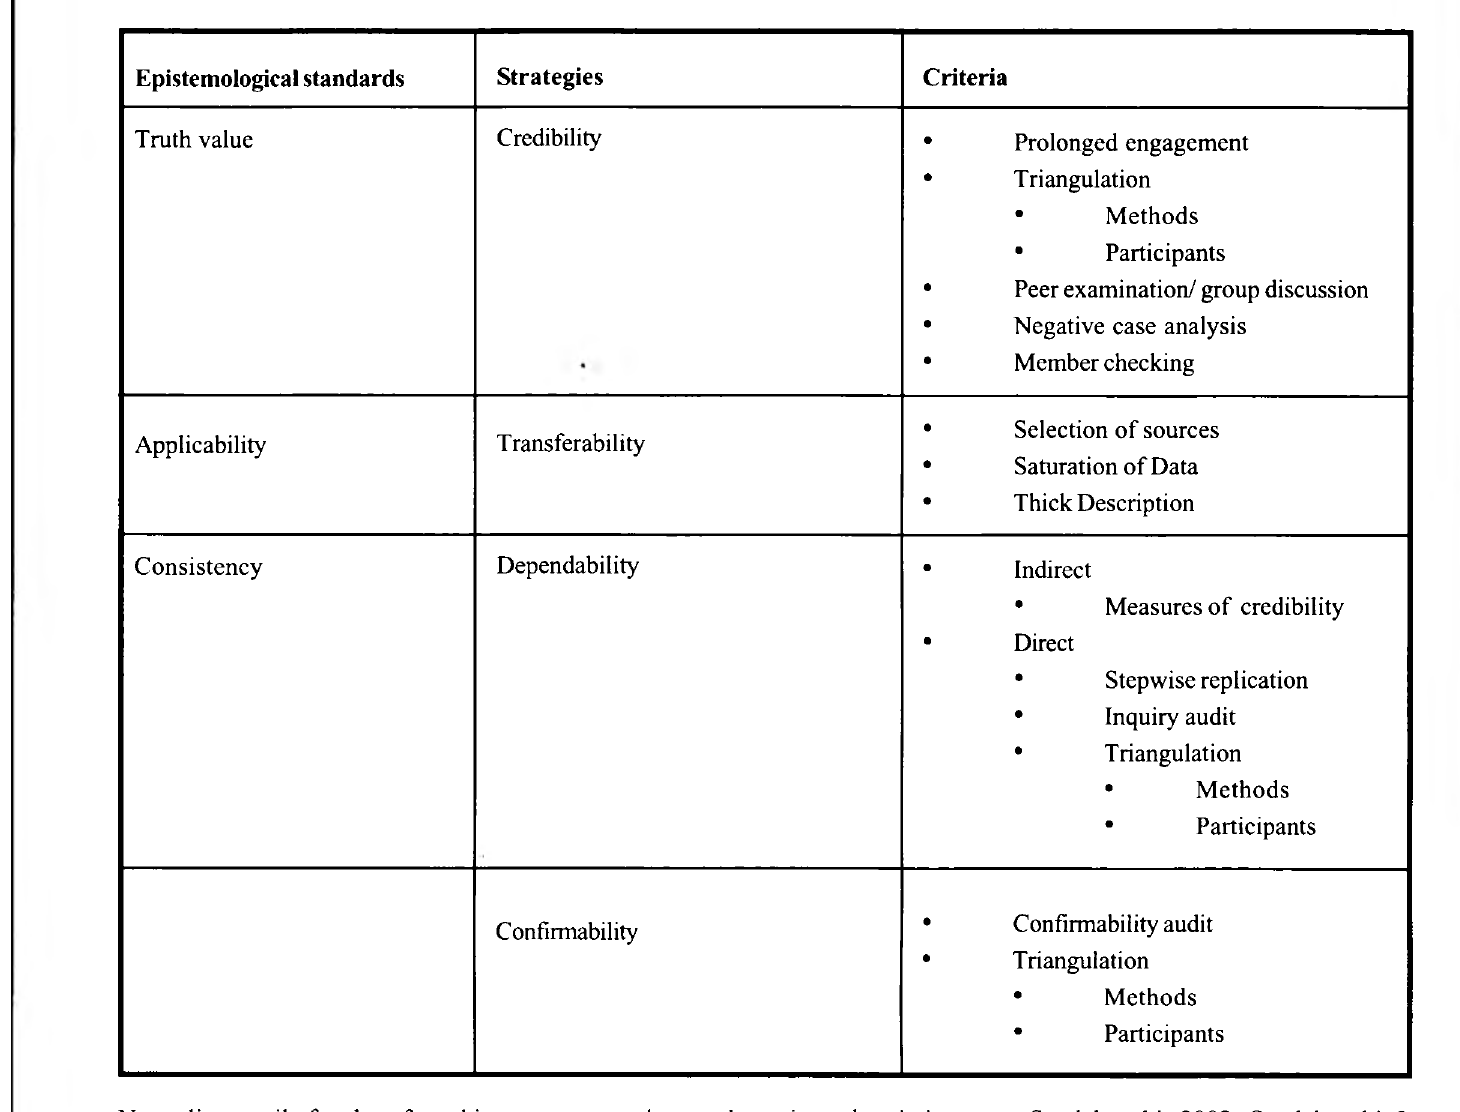
Table 3. Summary of standards, strategies and criteria to ensure trustworthiness Epistemological